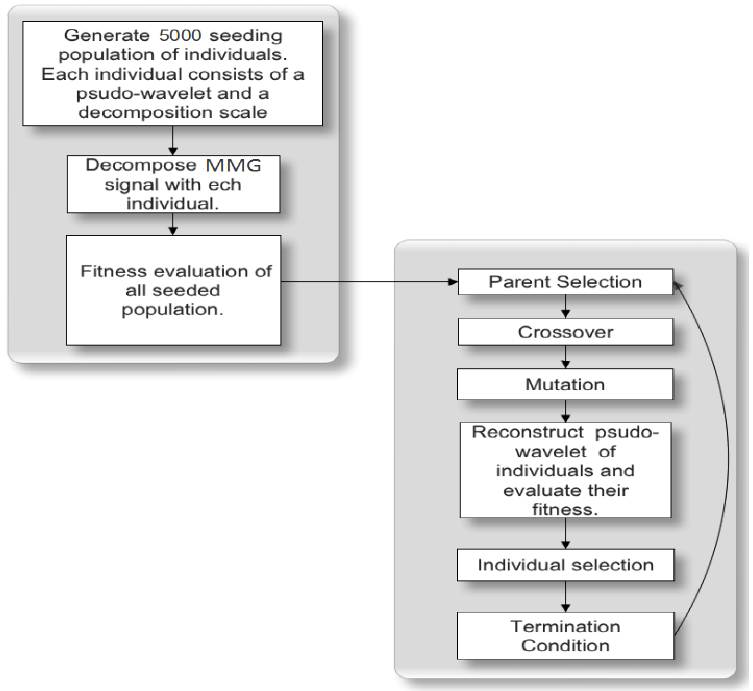
Figure 2. Flowchart of the pseudo-wavelet evolution.